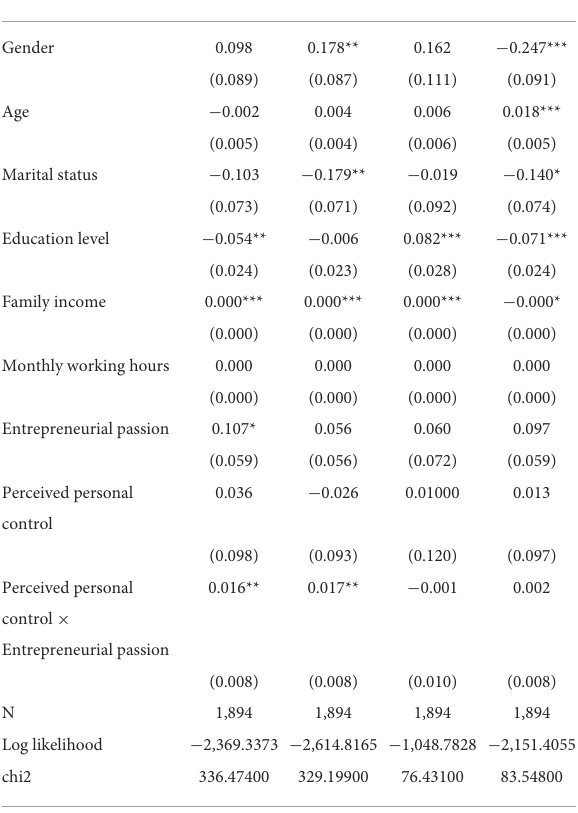
TABLE 3 The moderating effect test of perceived personal